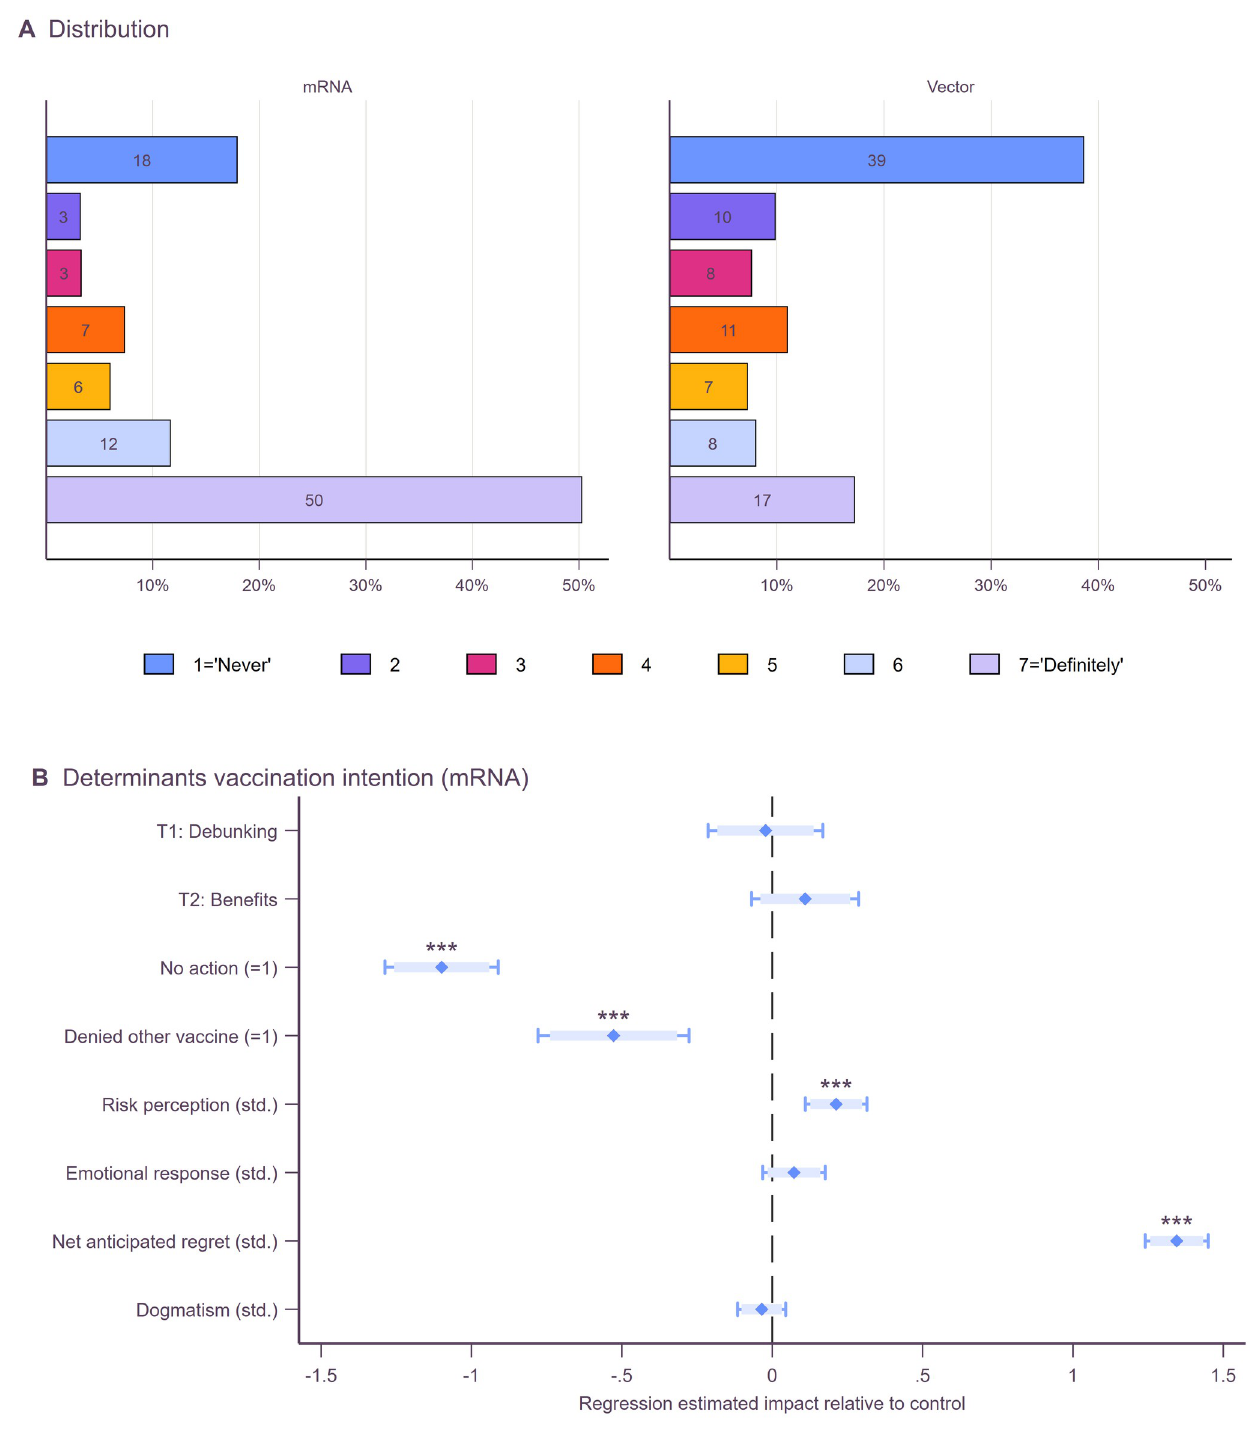
Fig 3. Vaccination intentions. Panel A shows vaccination intentions across treatments separately for mRNA and vector vaccines measured using 7-point Likert scales. Panel B plots regression estimates with vaccination intention (mRNA) as the dependent variable from ordinary least square regressions controlling simultaneously for the plotted variables and additionally for gender, age, education, adjusted household income, and marital status. Heteroskedasticity robust standard errors were used to compute 95% (thin bars) and 90% (thick bars) confidence intervals. Full regression outputs are reported in S9 Appendix, model 3 corresponds to the plotted estimates in panel